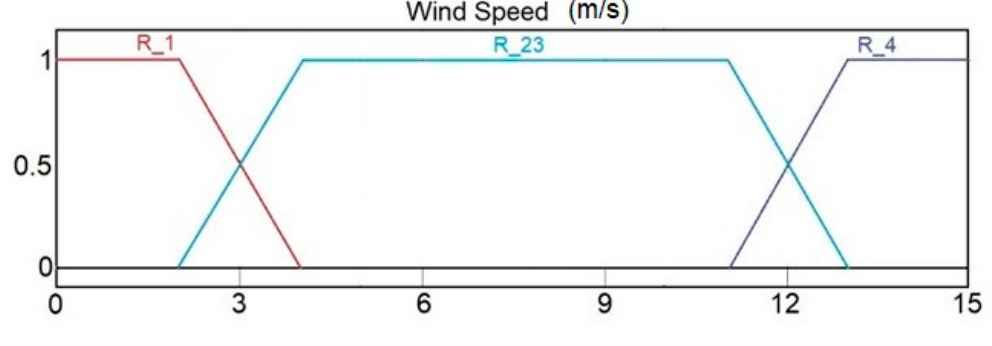
Figure 11. Membership functions for wind speed.